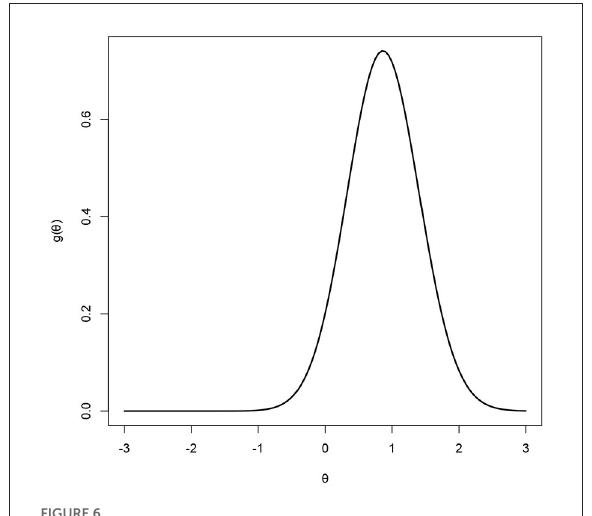
FIGURE6 Estimated Ramsay-curves for the real data set.